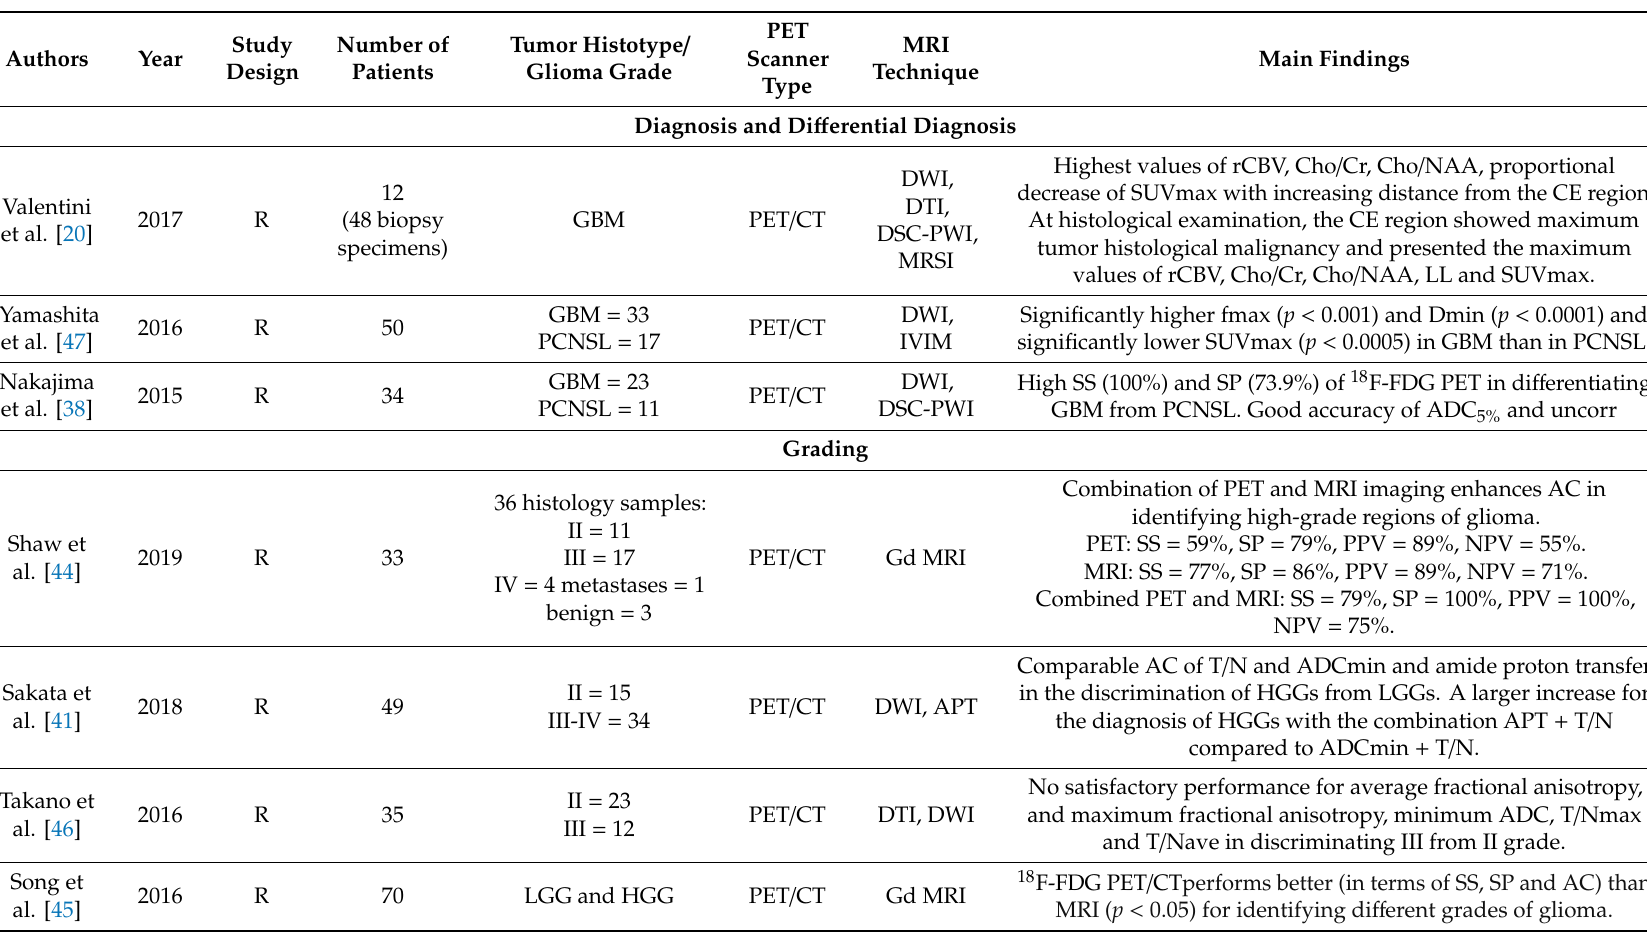
Table 1. Summary of the studies included in the